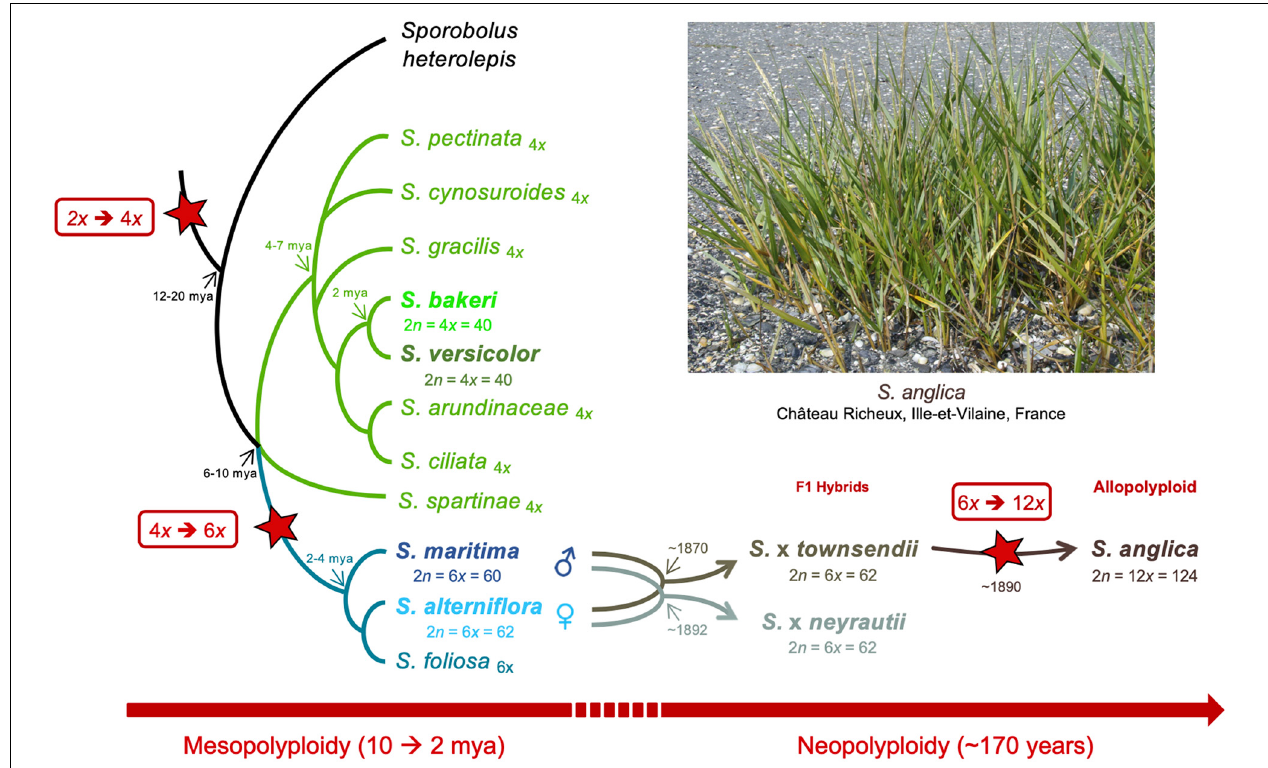
FIGURE 1 | Phylogenetic relationships among Spartina species (redrawn from Baumel et al., 2002a), and position of the analyzed tetraploid ( Spartina bakeri and Spartina versicolor ), hexaploid ( Spartina maritima , Spartina alterniflora , Spartina × townsendii , Spartina × neyrautii ) and dodecaploid ( Spartina anglica ) taxa analyzed in this study. Divergence times (my) represent upper limits estimated so far (Rousseau-Gueutin et al., 2015). Stars indicate whole genome duplication (WGD) events during Spartina